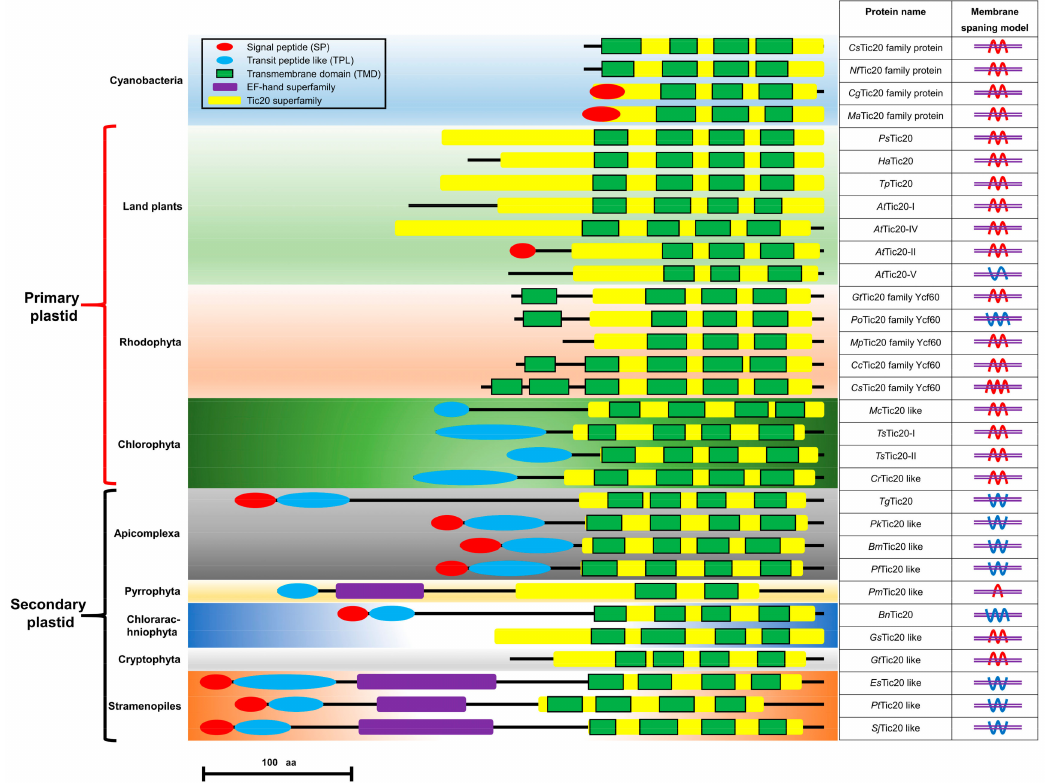
Figure 2. Schematic depiction of the structures and membranes of Tic20-like proteins in di ff erent organisms. SP: signal peptide (red oval), TPL: transit peptide-like sequence (blue oval), TMD: transmembrane domain (green box), EF-hand domain (purple box), Tic20 domain (yellow box). The membrane-spanning models were predicted by the constrained consensus topology prediction (CCTOP) tools. Red wavy lines represent both the N- and C-termini facing the inner part of the membrane; blue wavy lines represent both the N- and C-termini facing the outer part of the membrane or the antipodal orientation of the N- and C-termini; and violet double horizontal lines represent the membrane lipid bilayer. Protein item accession numbers are shown in Table